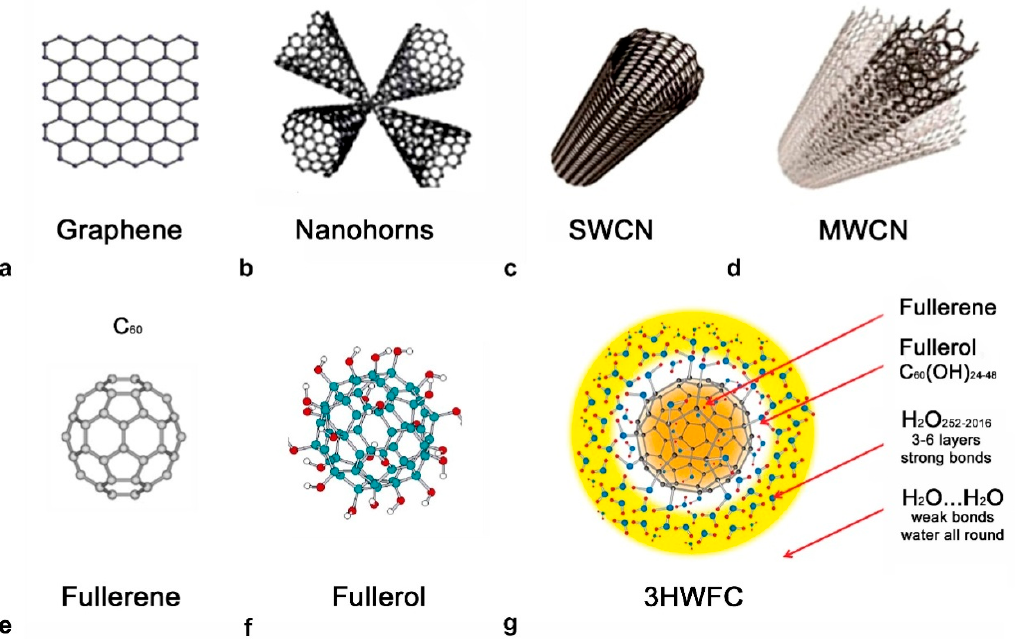
Figure 1. Different types of nanocarbon materials: ( a ) single sheeted graphene; ( b ) nanohorns; ( c ) single − walled nano tubes (SWCN); ( d ) multi − walled nanotubes (MWCN); ( e ) fullerene; ( f ) fullerol; ( c ) single–walled nano tubes (SWCN); ( d ) multi–walled nanotubes (MWCN); ( e ) fullerene; ( f ) fullerol; and ( g ) hydroxylated fullerene water complex (3HFWC). and ( g ) hydroxylated fullerene water complex